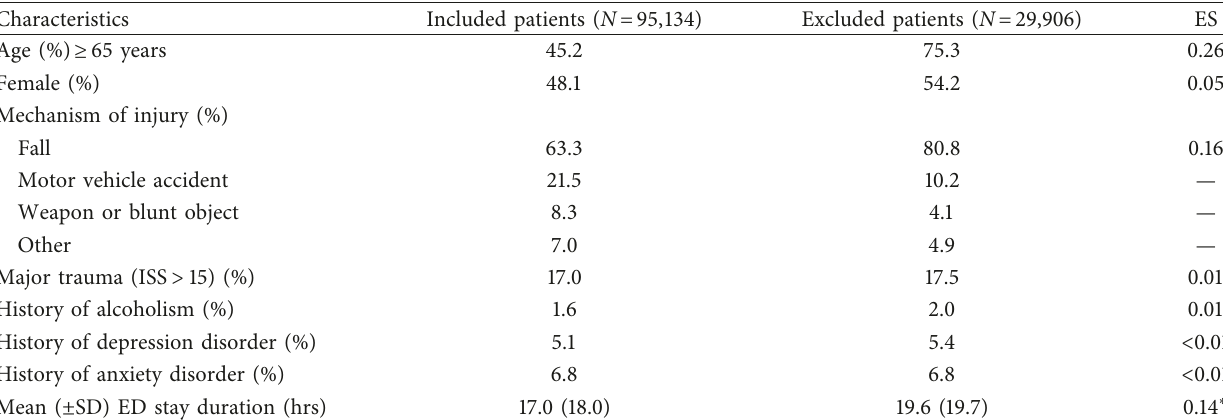
Figure 1: Flow chart of patients’ study inclusion. Table 1: Characteristics of included and excluded